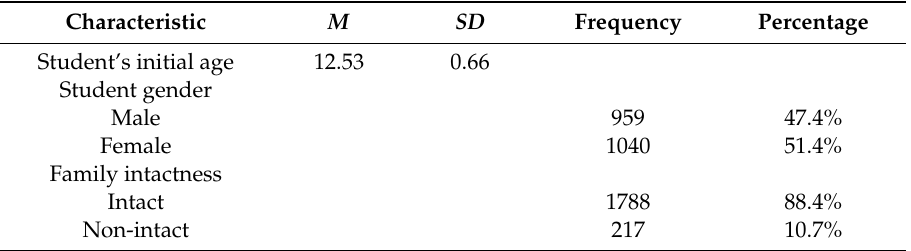
Table 2. The sample characteristics at Wave 1 ( N =